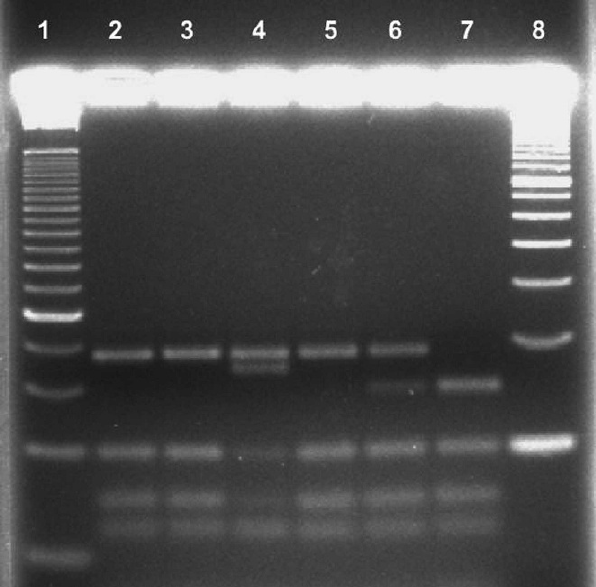
Figure 1 - The gel electrophoresis banding patterns used to genotype amplified DNA of study subjects digested with the HhaI restriction enzyme were as follows: (Column 1) 50-basepair DNA ladder; (Column 4) APOE2,3 genotype; (Column 5) APOE3,3 genotype; (Column 6) APOE3,4 genotype; (Column 7) APOE4,4 genotype; (Column 8) 100-basepair DNA